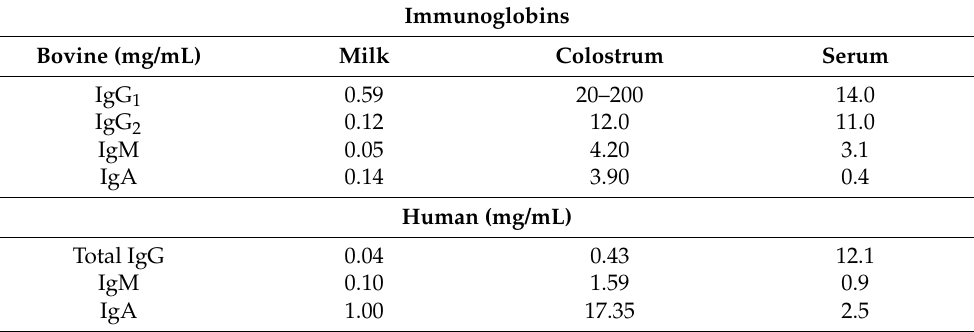
Table 1. Difference in immunoglobulin concentration between human and bovine